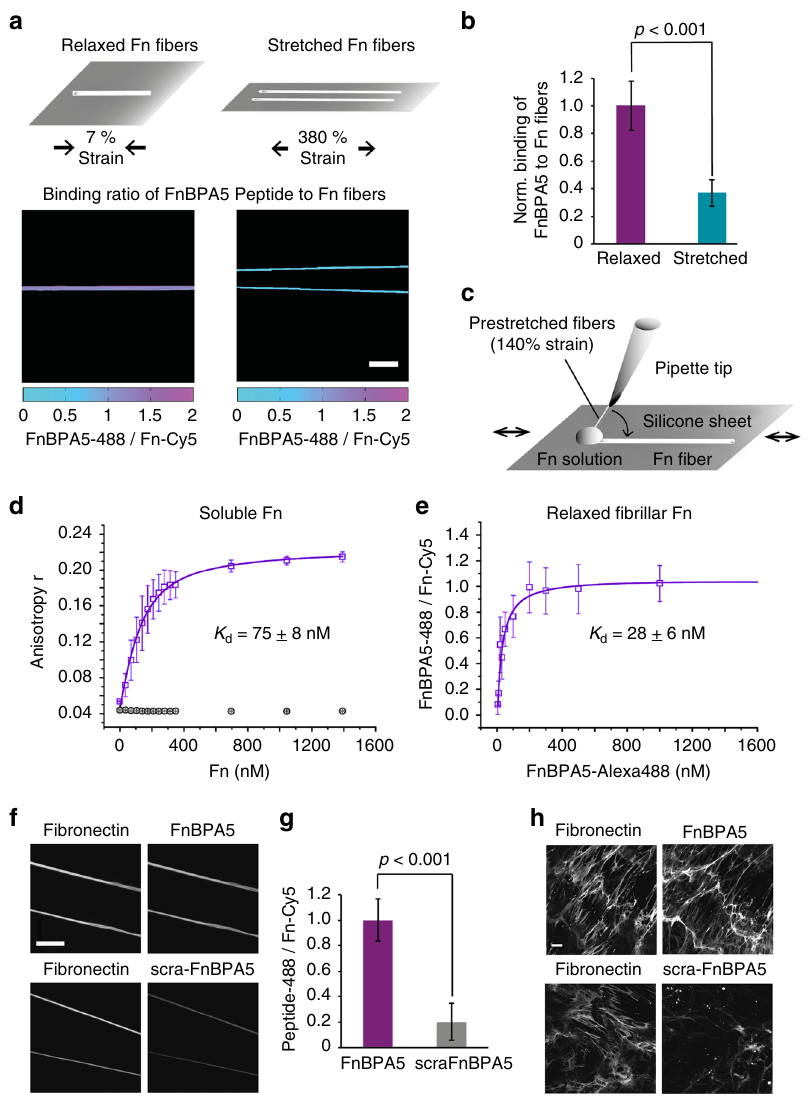
Fig. 2 In vitro binding studies of the peptide FnBPA5-Alexa-488 and the scrambled control (scraFnBPA5-Alexa-488) to soluble and fi brillar Fn. a Mechanosensitive binding of FnBPA5 was tested using relaxed (7% strain) and stretched (380% strain) fi bers. Color-coded intensity ratio images of FnBPA5-Alexa488 divided by Fn-Cy5 of manually pulled Fn fi bers of different mechanical state show higher binding to relaxed fi bers than to stretched ones, leading to a higher FnBPA5/Fn ratio (representative images). Scale bar, 50 μ m. b Normalized analysis of relaxed and stretched fi bers showing